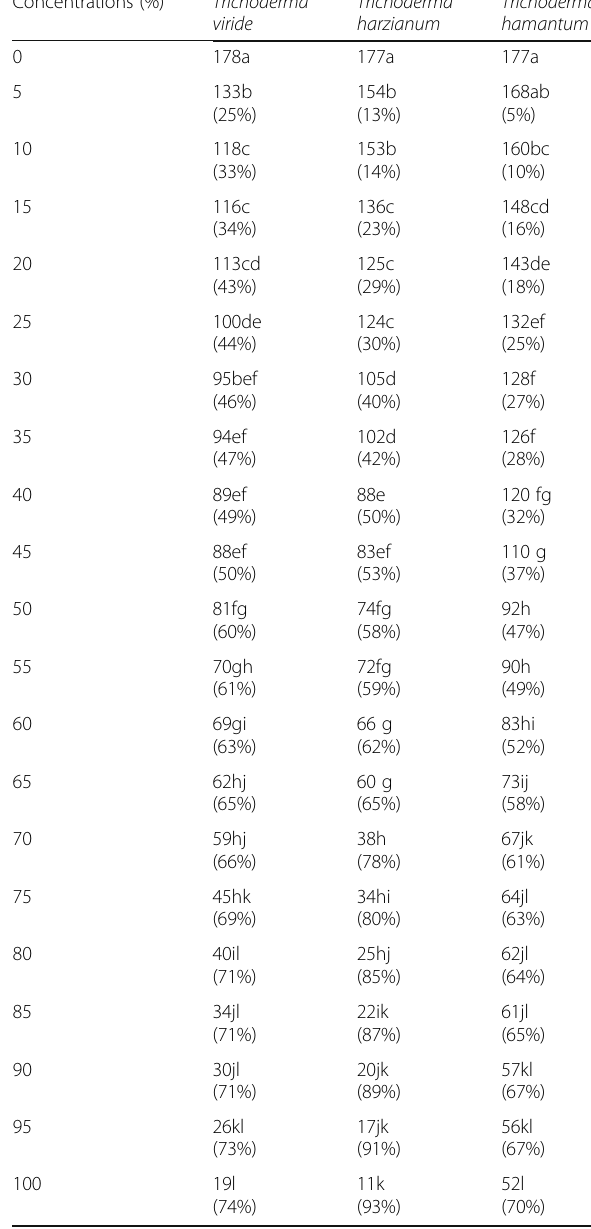
Table 2 Effect of methanolic extract of Melia azadarch